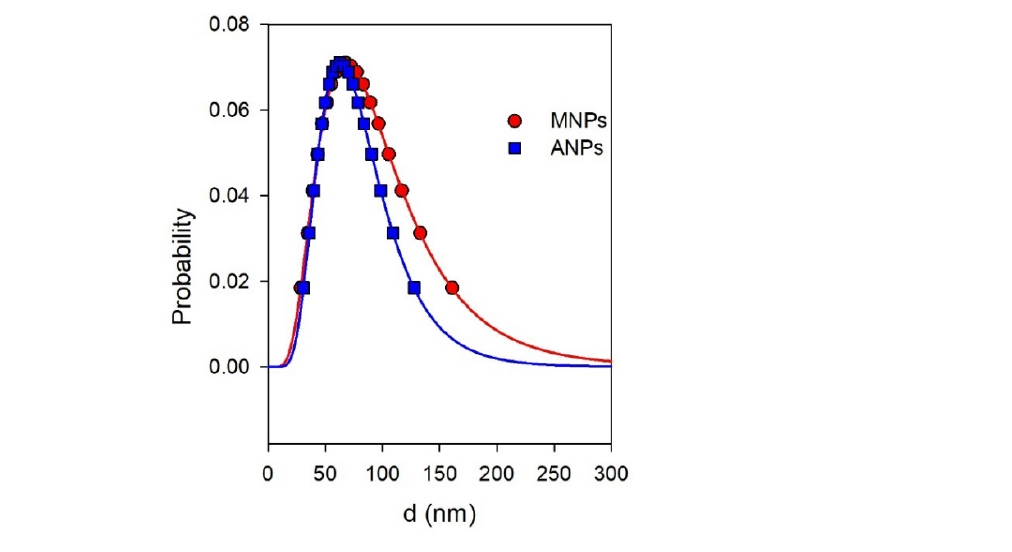
Figure 2. PSD of MNPs and ANPs in water suspensions measured by DLS. The probability function corresponds to the intensity of dynamic light scattering related to the fraction of nanoparticles with a certain diameter.